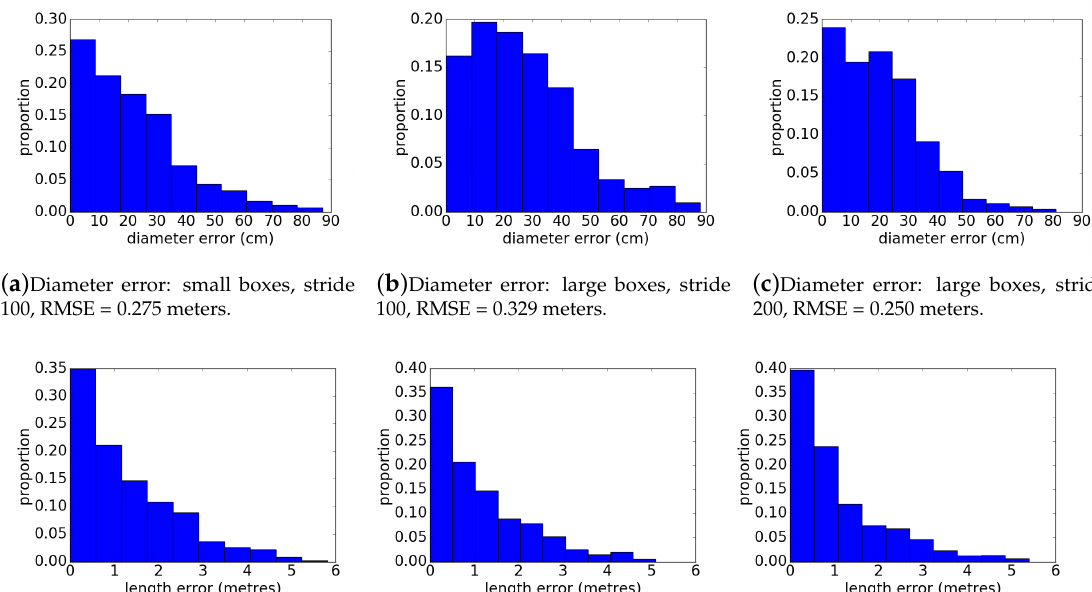
( d ) Length error: small boxes, stride 100, ( e ) Length error: large boxes, stride 100, ( f ) Length error: large boxes, stride 200, RMSE = 1.715 meters. RMSE = 1.573 meters. RMSE = 1.553 meters. Figure 10. Results for autonomous CWD rectangle fitting. The histograms are aggregated over all plots and folds. Each column corresponds to a different training strategy. ( a ), ( b ) and ( c ) plot the rectangle diameter error and ( d ), ( e ) and ( f ) plot the rectangle length error for the different strategies.